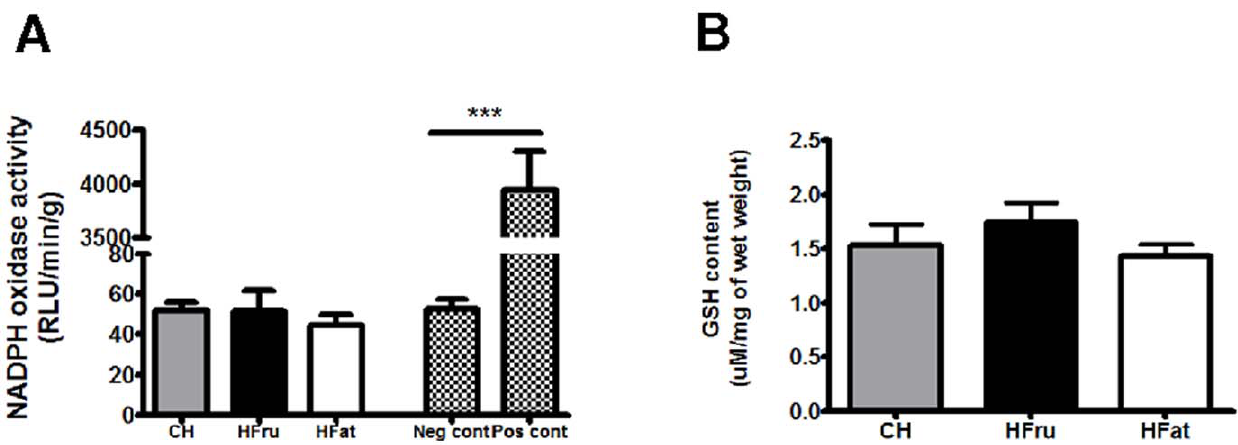
Figure 5. Effects of HFru and HFat feeding on oxidative stress. After one week of HFru or HFat feeding, the activity of NADPH oxidase ( A ) and intracellular GSH content ( B ) were quantified in liver homogenates, data are mean 6 SE of 6 to 8 mice per group. *** p , 0.001.